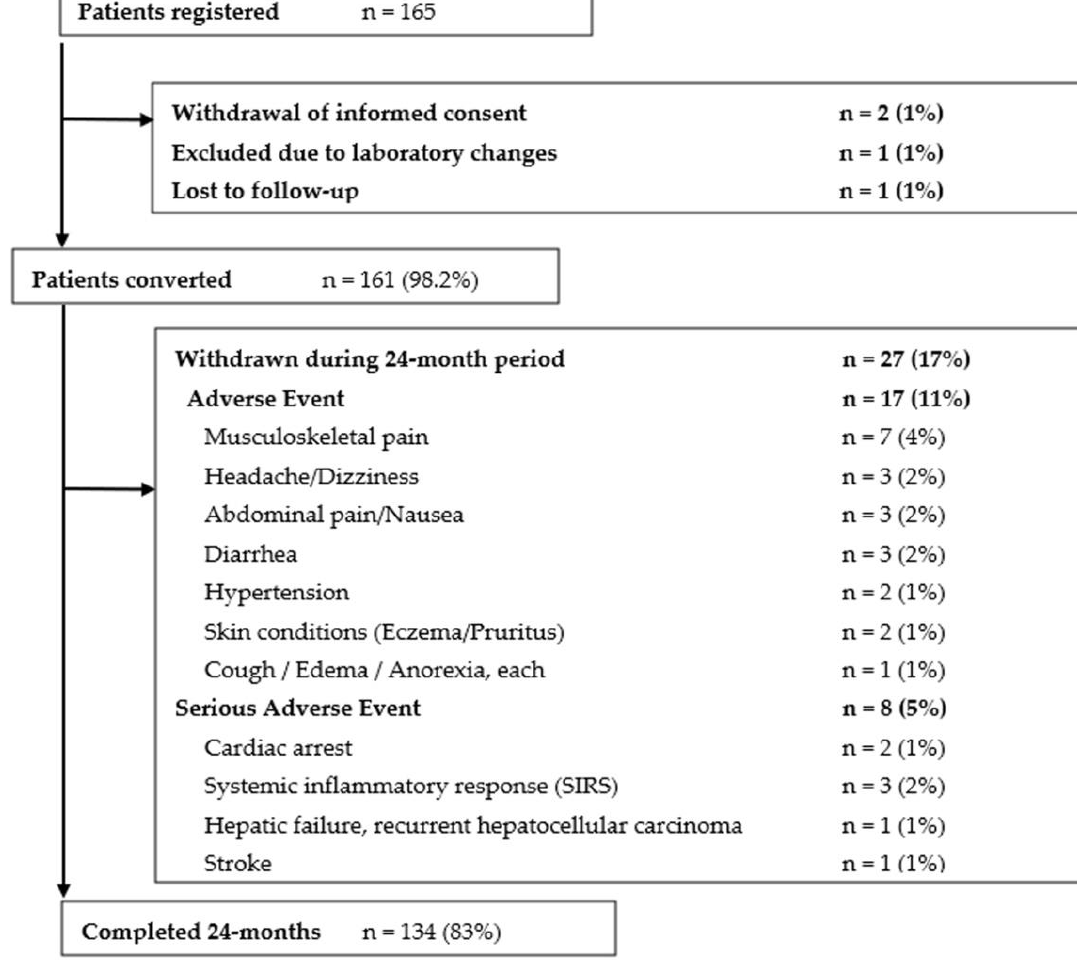
Figure 2. Patient Figure 2. Patient disposition. Table 1. Descriptive characteristics of the study group at baseline, means ± SD, median (range) or N (%).